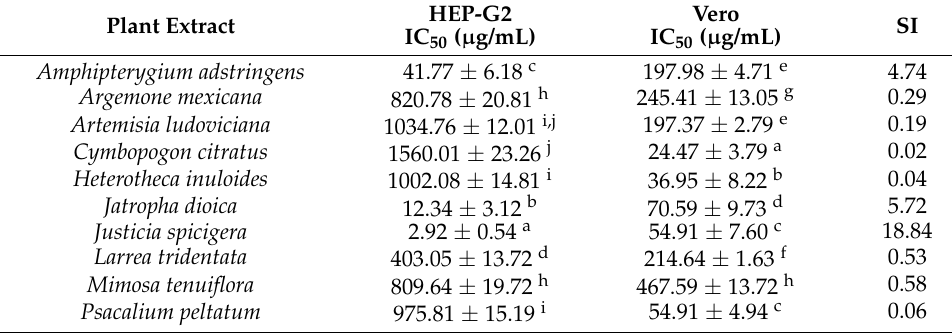
Table 2. Cytotoxic activity of Mexican plant extracts against HEP-G2 tumor cells and Vero non- tumor